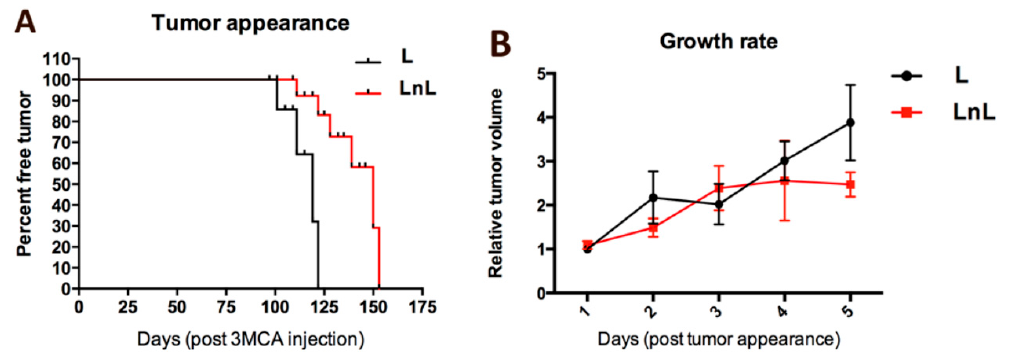
Figure 4. Development of fibrosarcomas is delayed in mice from the LnL group. ( A ) Curves report- ing the appearance of palpable tumors from L and LnL mice. ( p < 0.01; χ 2 test); ( B ) relative tumor volume (mean ± SEM) over the interval of time between tumor appearance and mouse sacrifice (n.s., Mann–Whitney U test for each day). Mann–Whitney U test for each